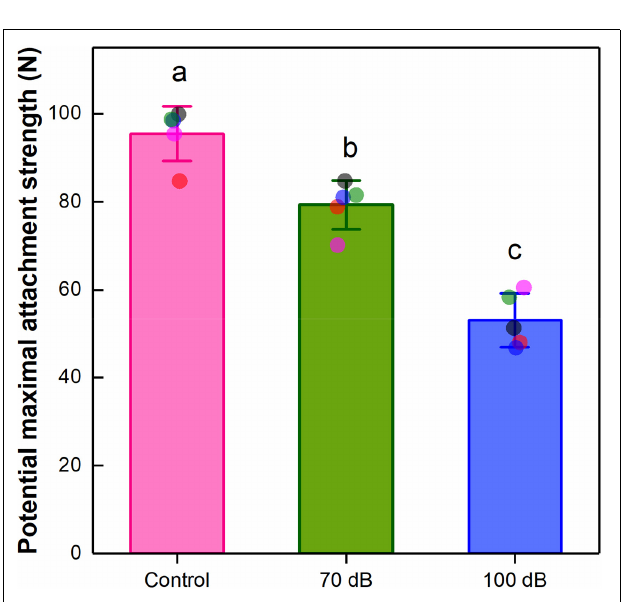
FIGURE 5 | Effects of anthropogenic noise exposure on the potential maximal attachment strength of the thick shell mussel Mytilus coruscus ( n = 5 per group, mean ± SD). Means not sharing the same superscript are significantly different (Tukey’s HSD, p <